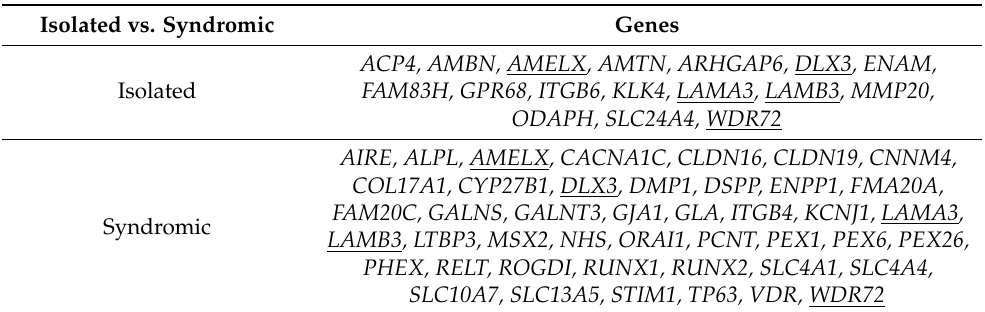
Figure 1. The flowchart for literature mining based on the Preferred Reporting Items for Systematic Reviews and Meta-Analyses (PRISMA) guideline, including the sequential steps for the identification, screening, eligibility check, and qualification of the literature. Table 1. Genes associated with isolated or syndromic amelogenesis imperfecta.